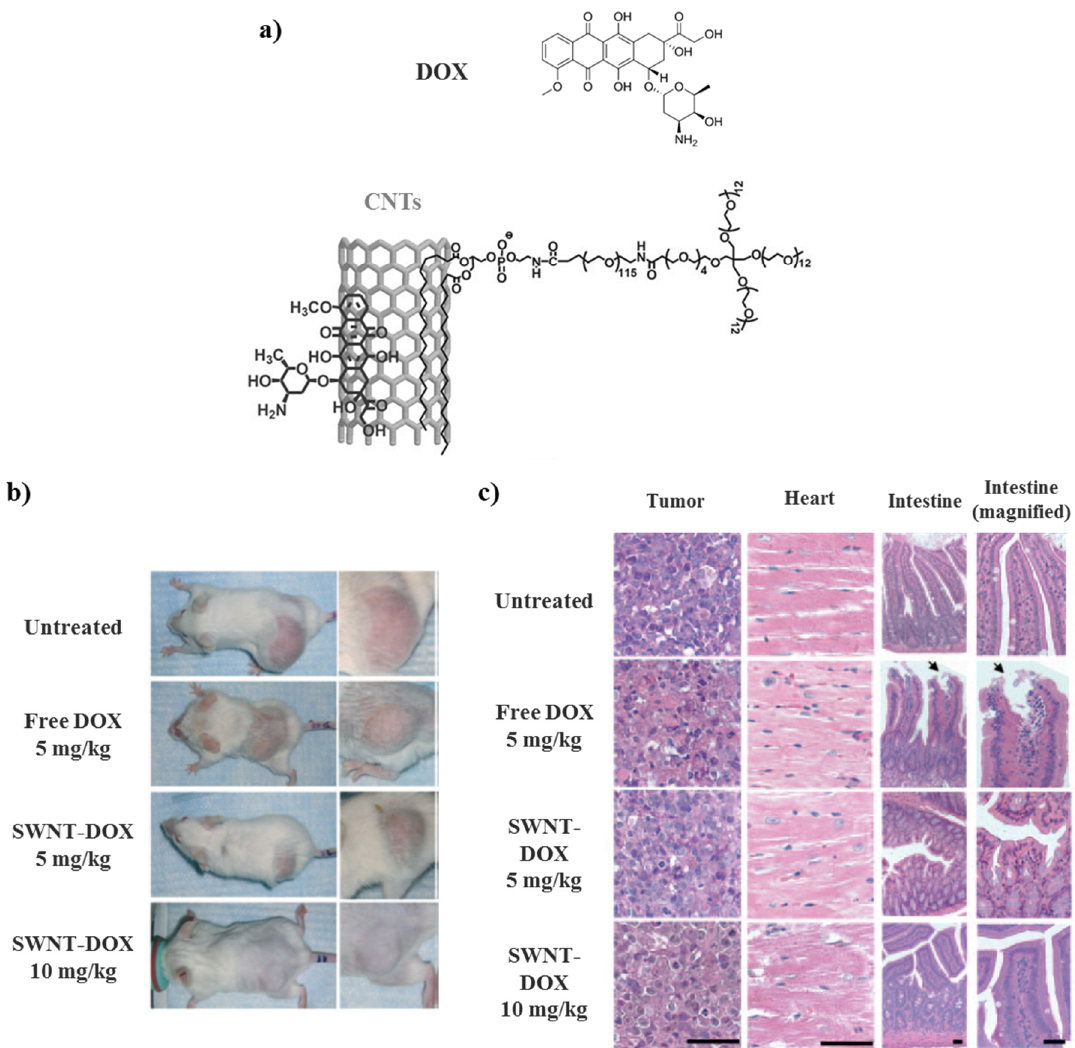
Figure 13. Schematic illustration of drug delivery systems comprising SWNTs. (a) A scheme showing non-covalent supramolecular π – π stacking of DOX with SWNTs. (b) Representative photos of mice from different groups were taken after treatments with DOX. (c) Gastrointestinal toxicity was observed in mice treated with free DOX but not in mice treated with SWNT-DOX. Histological sections of intestinal epithelium showed damage of the intestinal epithelium in the free DOX treated group. The arrows show the area of loss of columnar epithelial cells in tips of villi. (Scale bars: 100 micrometers). Reprinted with permission from [88]; copyright (2009) Wiley-VCH.